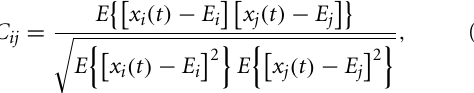
FIGURE 10 | Transient synchronization in response to stimulation. (A) Spike raster showing responses of 100 neurons from a relay network to a strong external current ( I ext = 30 μ A, solid black line) followed by a weak current ( I ext = 5 μ A, solid gray line). Gain inhibition of the relay neurons was set to g inh = 2 . 25nS (50% higher than baseline) throughout the simulation.